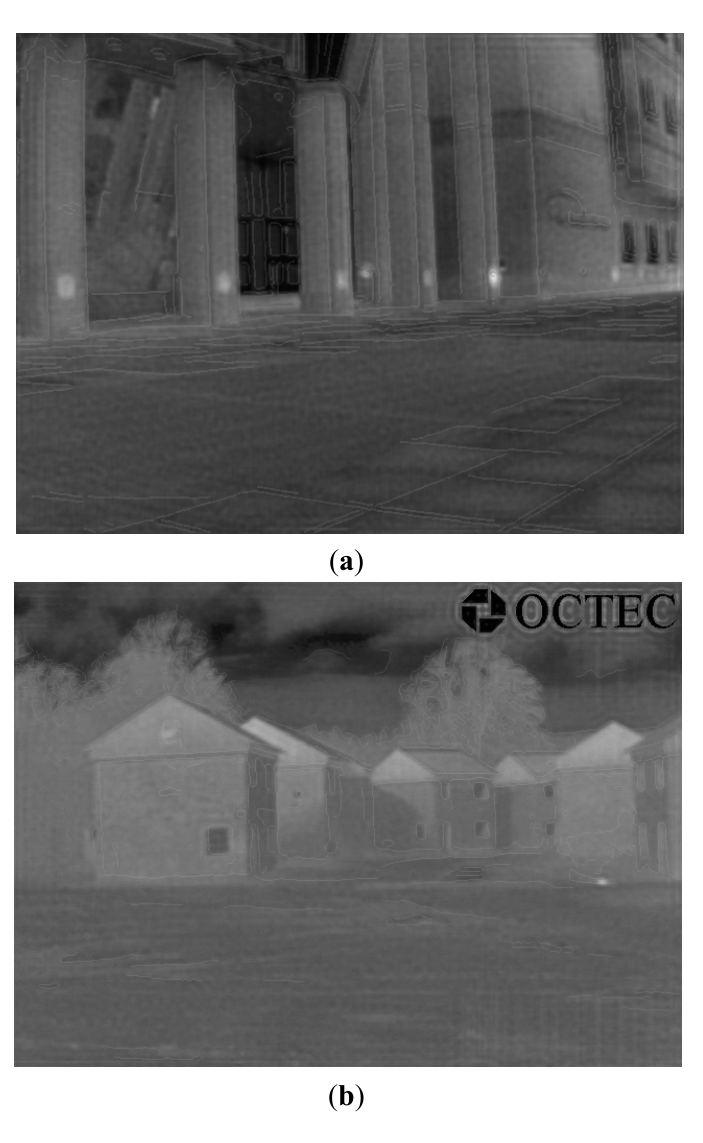
Figure 6. Blended images generated with both EO and IR images. ( a ) Blended result of IR Image 1; ( b ) Blended result of IR Image